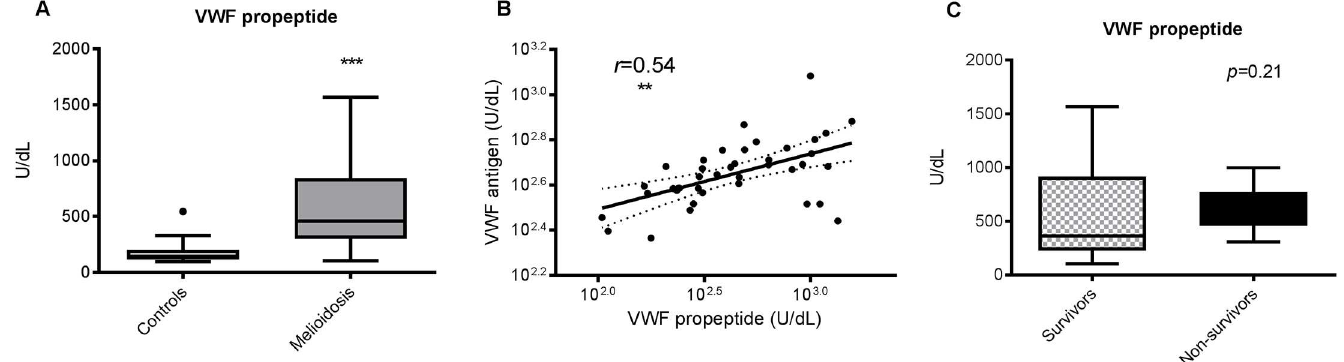
Fig 3. VWF propeptide concentrations are elevatedin melioidosis (A) and correlate with VWF antigen levels (B), but do not correlate with mortality (C). VWF = von Willebrand factor. The data from 34 melioidosis patients (of whom 12 died) and 52 controls are presentedas box plots with Tukey whiskers showingthe smallest observation, lower quartile, median,upper quartileand largest observation. *** P < 0.001for the difference between patients and controls; (Student’s t-test); P = 0.21 for the difference betweensurvivors (n = 22) and non-survivors (n = 12). For the scatter plot, each dot represents a singlestudy subject from the patient group only (n = 34); the correlationcoefficient and * P < 0.05 reportedare for Pearson’s r . The correspondingregression line for the scatter plot is drawn in bold, with the 95% confidenceinterval for the regression line marked by interruptedlines.